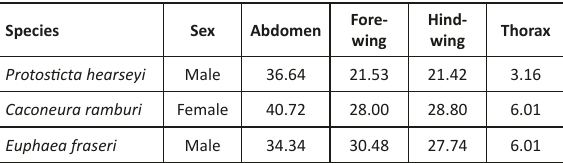
Table 2. Morphometry of Protosticta hearseyi, Caconeura ramburi and Euphaea fraseri . All measurements in mm. Species Sex Abdomen